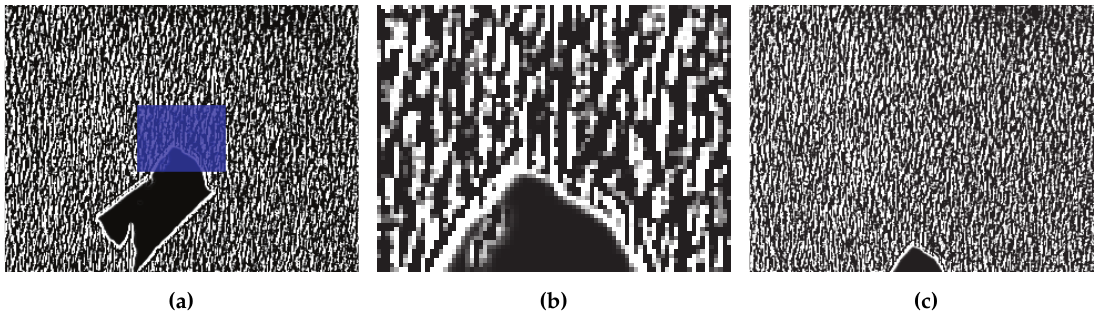
Figure 17. The location of the template image ( a ); the extracted template used for tracking purposes ( b ); and the image that was searched ( c ).